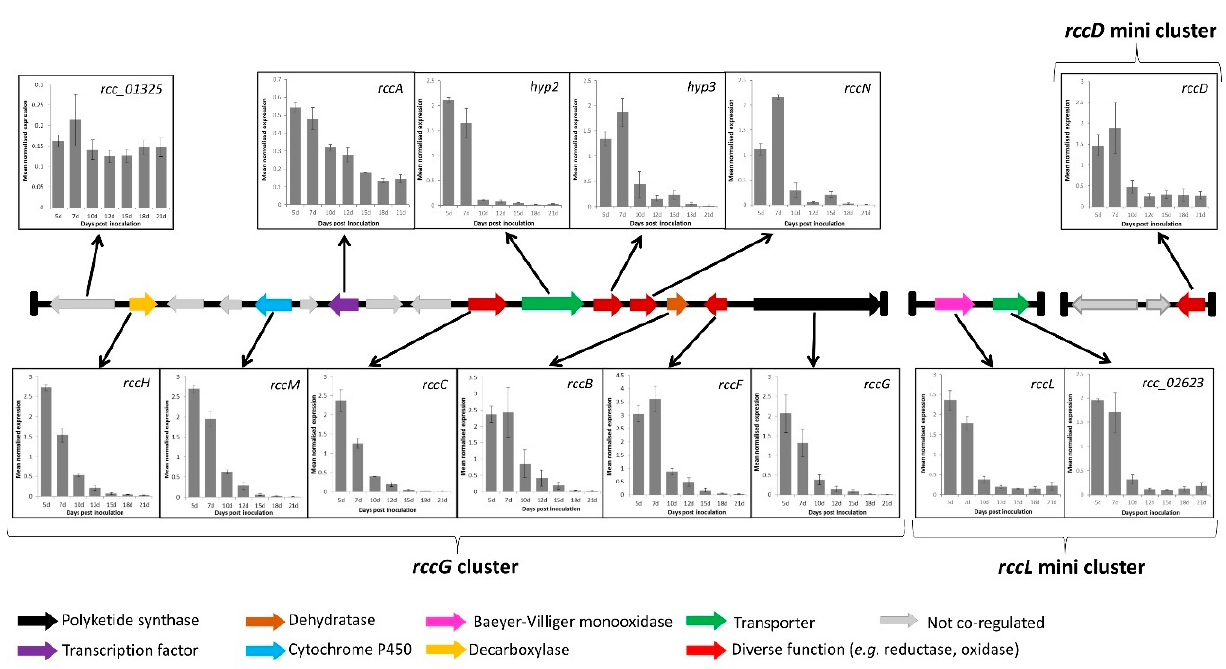
Figure 4. Expression of genes in the rubellin candidate biosynthetic cluster during disease develop- ment in artificially inoculated barley seedlings. Disease development was previously described by Dussart et al. [26]. Early symptoms appearance was recorded at 7 dpi, with typical lesions being clearly visible after 10 dpi. Genes represented in grey did not appear to be coregulated based on the RNA-seq data published by McGrann et al. [43]. The expression profile of gene Rcc_01325 was used to validate the results of the RNA-seq data. Data show mean normalised expression value ± standard error of three independent experiments.